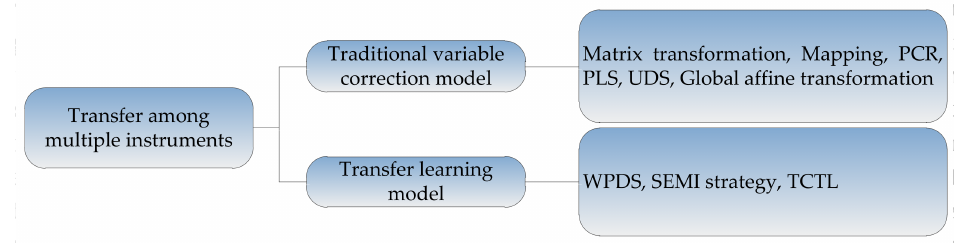
Figure 6. Methods for suppressing the transfer among multiple